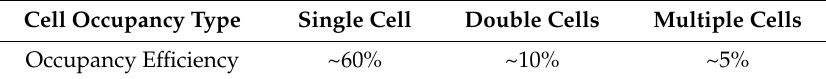
Figure 4. Evaluation of single cell occupancy efficiency using the fluorescence-based detection.